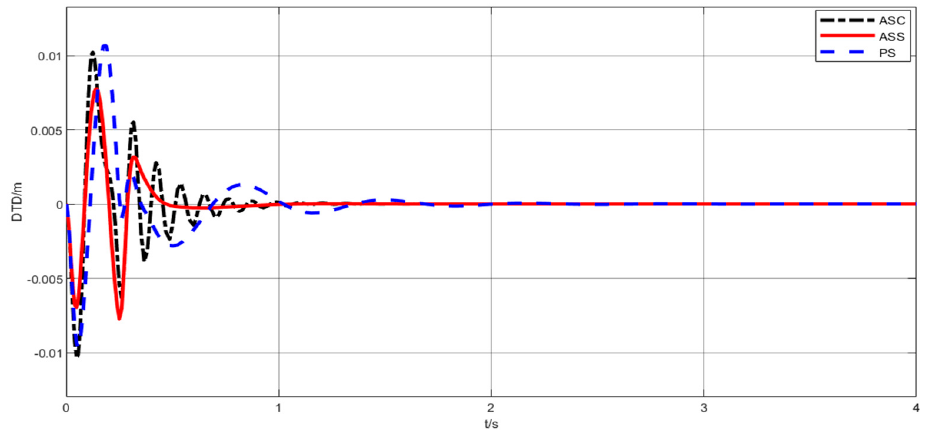
Figure 15. Bump dynamic tire displacement responses of different suspensions with 20% mass variation.